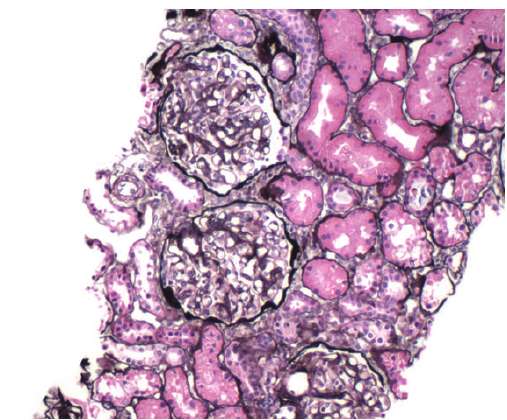
Figure 1: Light microscopy of renal biopsy with Jones’ silver stain.